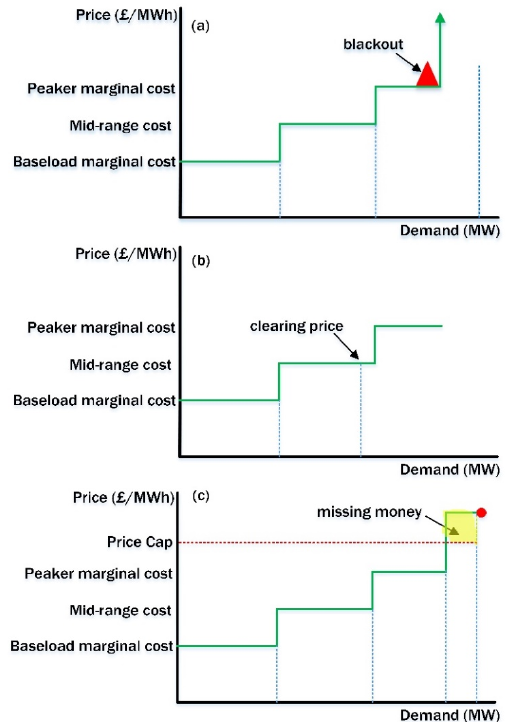
Figure 1. Energy price and demand for different generators during: ( a ) blackout; ( b ) normal operation; ( c ) period of scarcity.